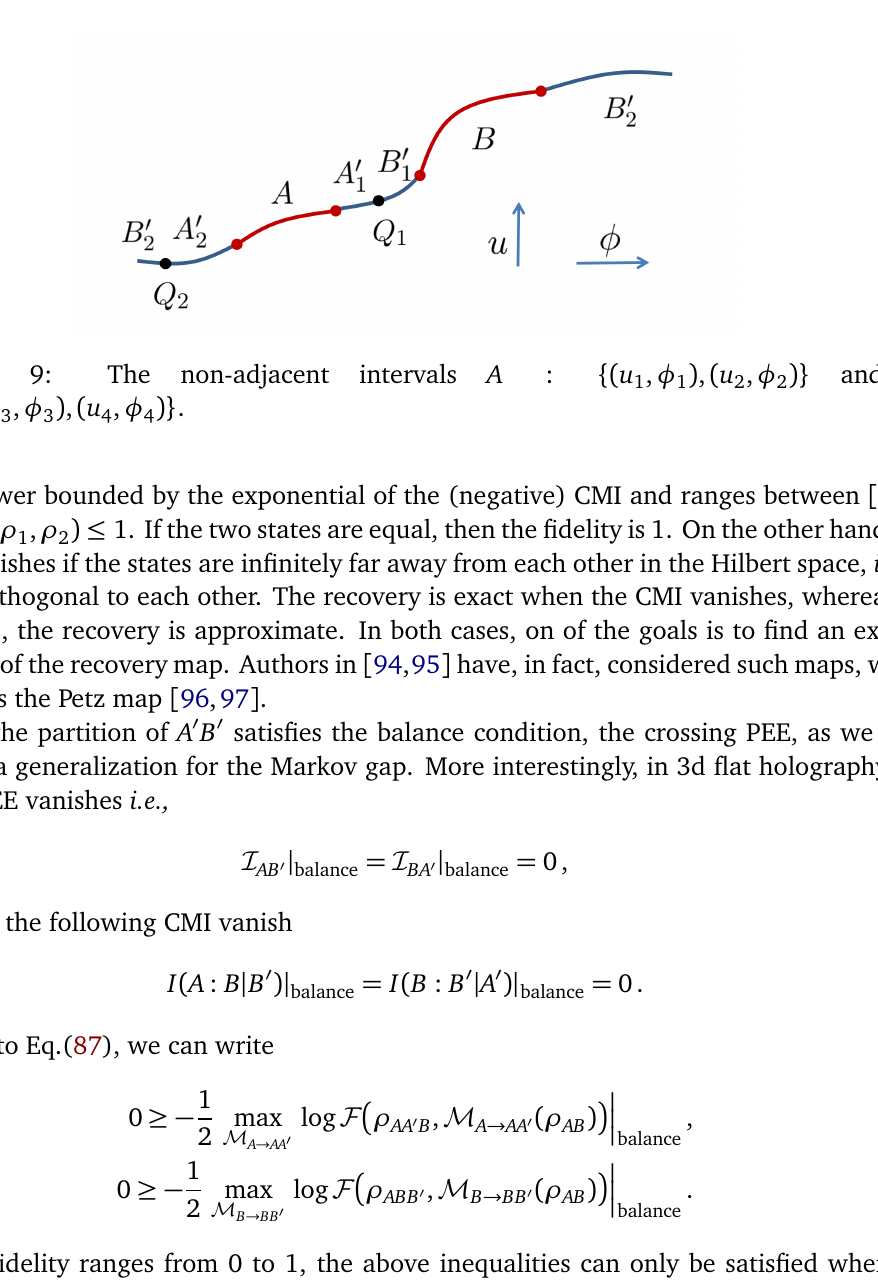
) , ( u ) } and , φ , φ 1 1 2 2